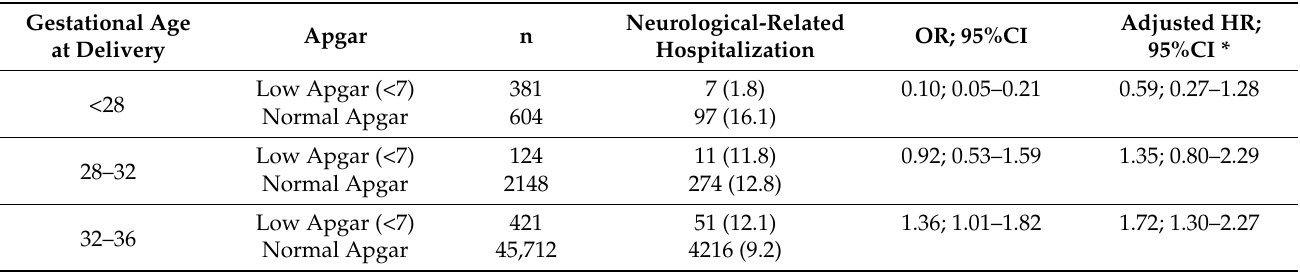
Table 4. Incidence and multivariable analysis for total neurological-related hospitalizations among offspring born preterm